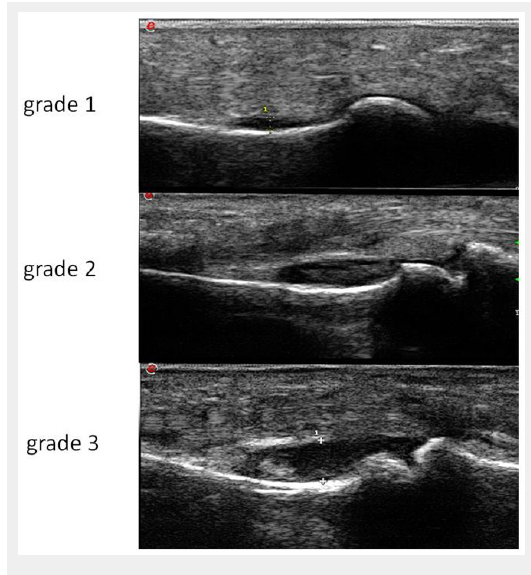
Synovitis grade 1-3, PD activity: dorsal view of a metacarpo- phalangeal joint. Presence of an